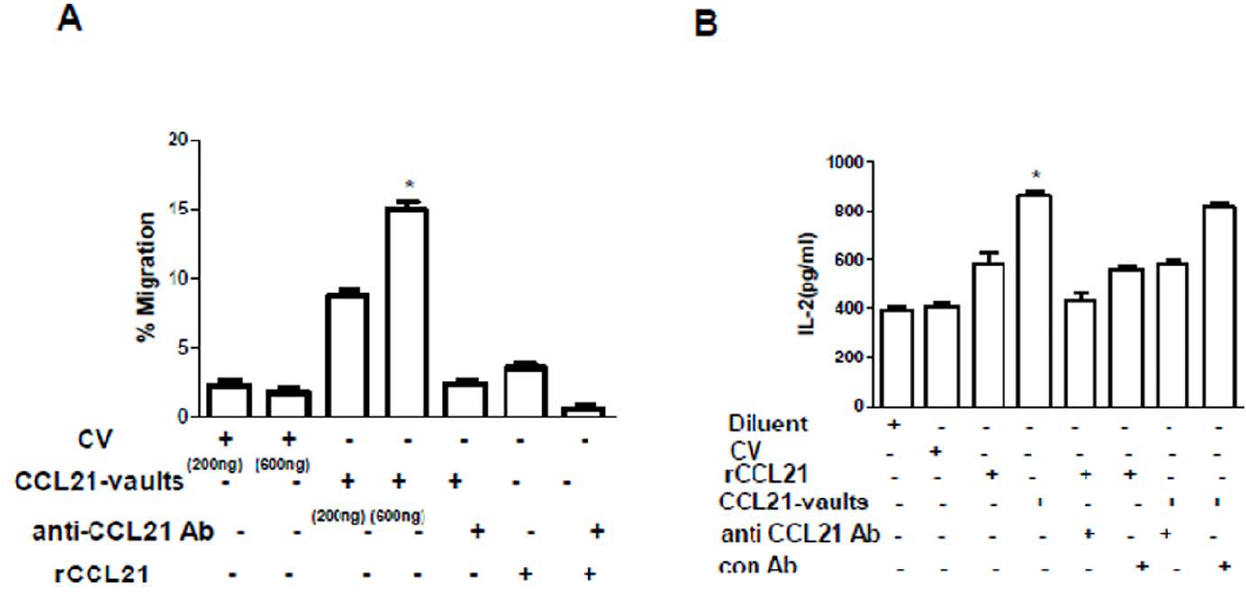
Figure 2. CCL21-vaults enhance the chemotactic migration of T cells and DC APC activity. A. CCL21-vaults increased the migration of T2 cells. 2.0 6 10 5 T2 cells were plated in serum-free medium in the upper chamber. mCCL21-mCherry-INT/CP-MVP vaults (200 ng/ml or 600 ng/ml), recombinant CCL21 (600 ng/ml), control vaults (CP-MVP vaults 600 ng/ml) or neutralizing anti-CCL21 recombinant antibody (5 m g/ml) were added to the lower chamber of the wells. Following 2 hr incubation, migration of T2 cells were analyzed by flow cytometry. mCCL21-vaults effectively increased the T2 migration as compared with control. Anti-CCL21 neutralizing Ab to CCL21 abrogated the increase in T2 migration suggesting that CCL21 in the vault predominantly mediate the chemotatic migration of T2 cells. Data in the panel are representative of 2 independent experiments. Bars; Mean 6 SEM, *p , 0.05 between the mCCL21-vaults and control vaults or anti-CCL21 antibody treatment groups. B. mCCL21-vaults enhanced DC APC activity and blocking CCL21 reversed the increase in APC activity. B3Z cells (1 6 10 5 cells/200 m l/well) were co-cultured with DC 2.4 (5 6 10 4 cells/200 m l/well) and ovalbumin (350 m g/ml) in the presence or absence of mCCL21-vaults (200 ng/ml) and anti-CCL21 antibody (5 m g/ml) or control antibody (5 m g/ml goat IgG) for 24 hrs. Control vaults were used at a concentration of 200 ng/ml. T cell activation status was measured by IL-2 production by ELISA. Data are representative of 2 independent experiments. Bars; Mean 6 SEM, *p , 0.05 between the mCCL21-vaults and control vaults or anti-CCL21 antibody treatment